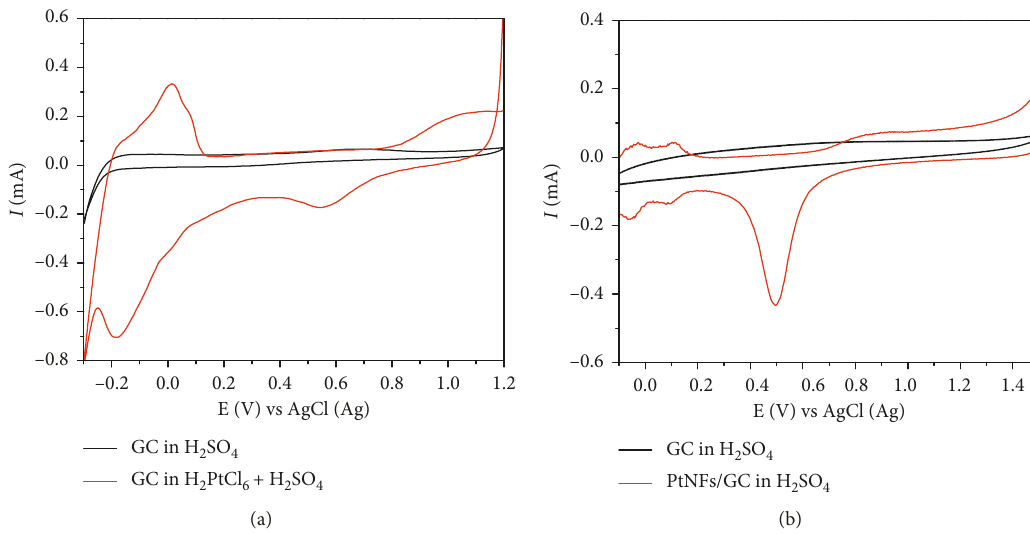
Figure 1: The cyclic voltammograms of a glassy carbon electrode in 0.1M · H 10.0mM · H 2 PtCl 6 solution (a); a glassy carbon electrode and Pt/GCE in 0.1M · H 2 SO 4 solution (b), scanning rate of 0.1